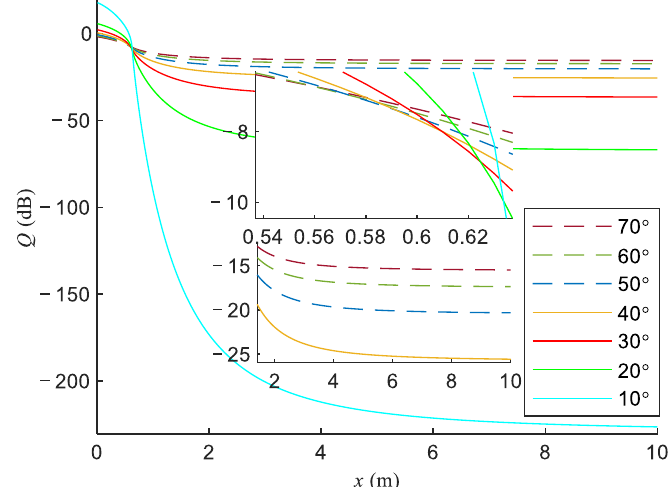
Figure 5. Calculation results of the relationship between the Q and x in the situation of a single infinitely long wall.